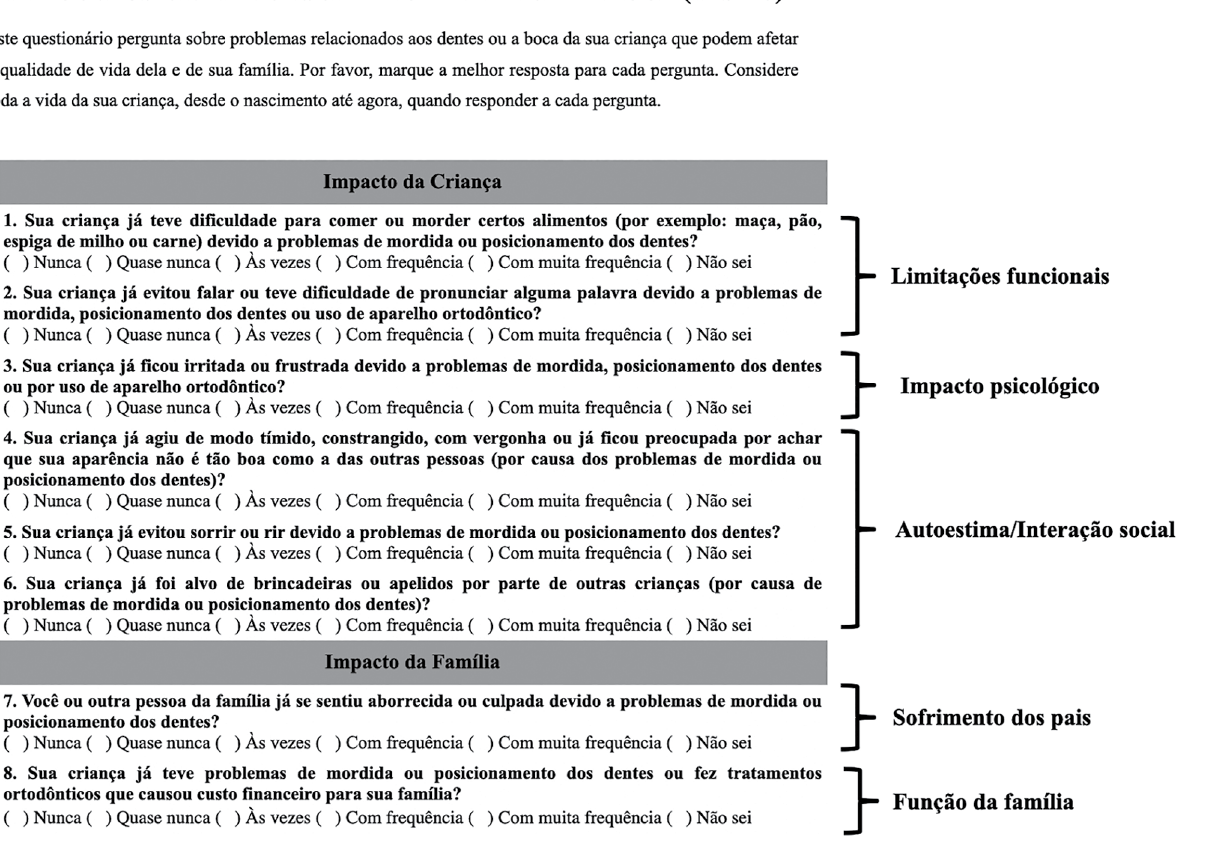
Figure 1. The Malocclusion Impact Scale for Early Childhood (MIS-EC) in Brazilian Portuguese